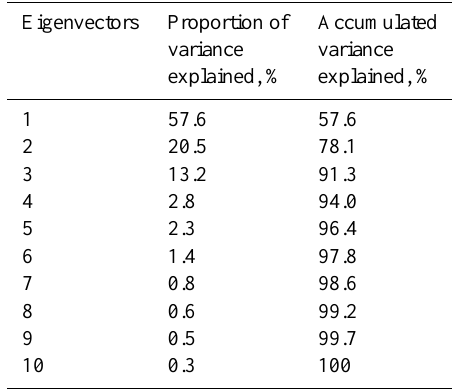
Table 2. Variance explained by each eigenvector ( n =